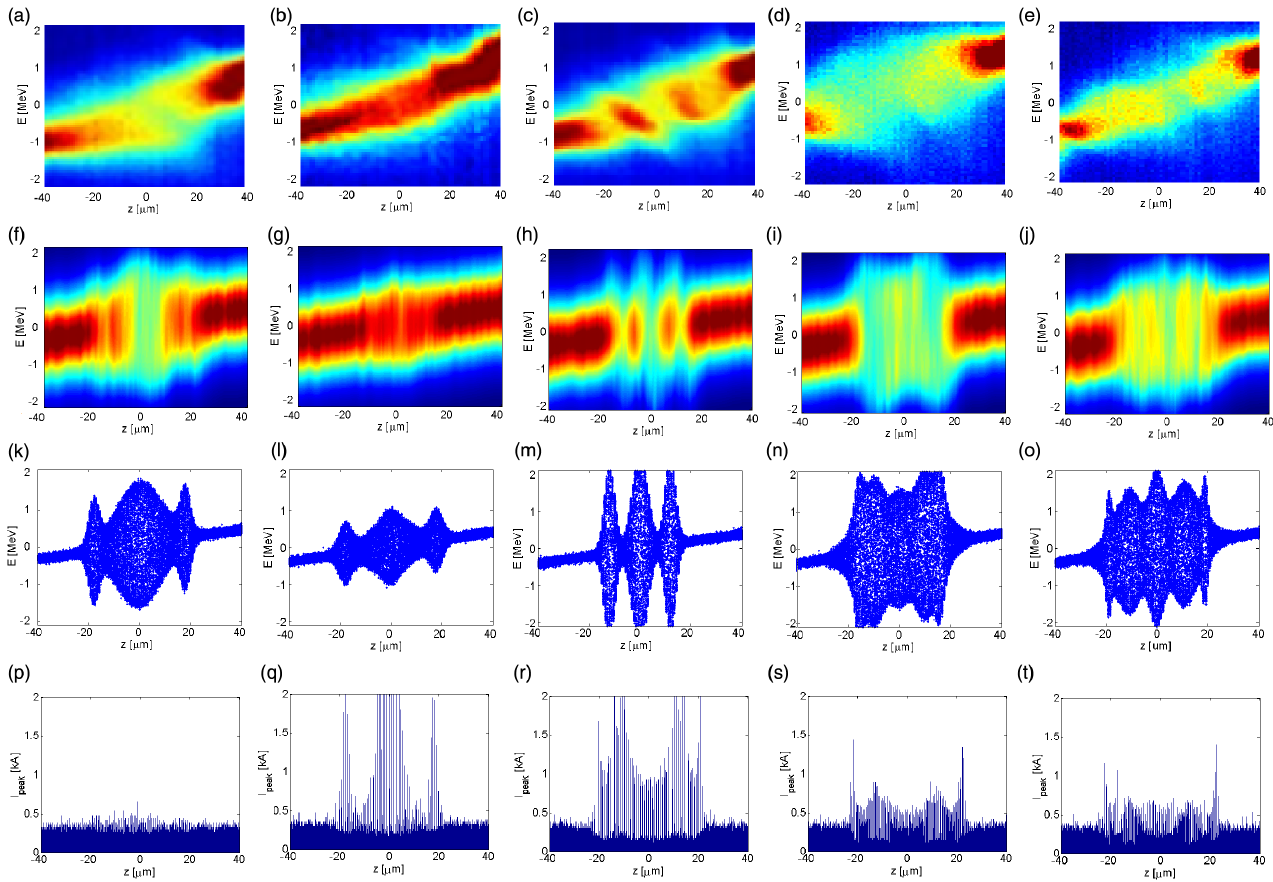
FIG. 7. Comparison of rf deflector measurements (a – e) with simulations of the measurements (f) – (j). The color code was tuned so that it was consistent across all measurements and simulations. Simulated longitudinal phase space distributions at the cavity entrance (k) – (o) and the longitudinal current distributions at the entrance to the drift (p) – (t) are below. The vertical dispersion in the horizontally deflecting spectrometer was turned off in the simulation and that is why the seeded region in the simulations (f) – (j) is not tilted, while the seeded region in the measurements (a) – (e) is. The screen is rotated by 90 degrees, making the horizontal spectrometer deflection appear in the vertical direction on the